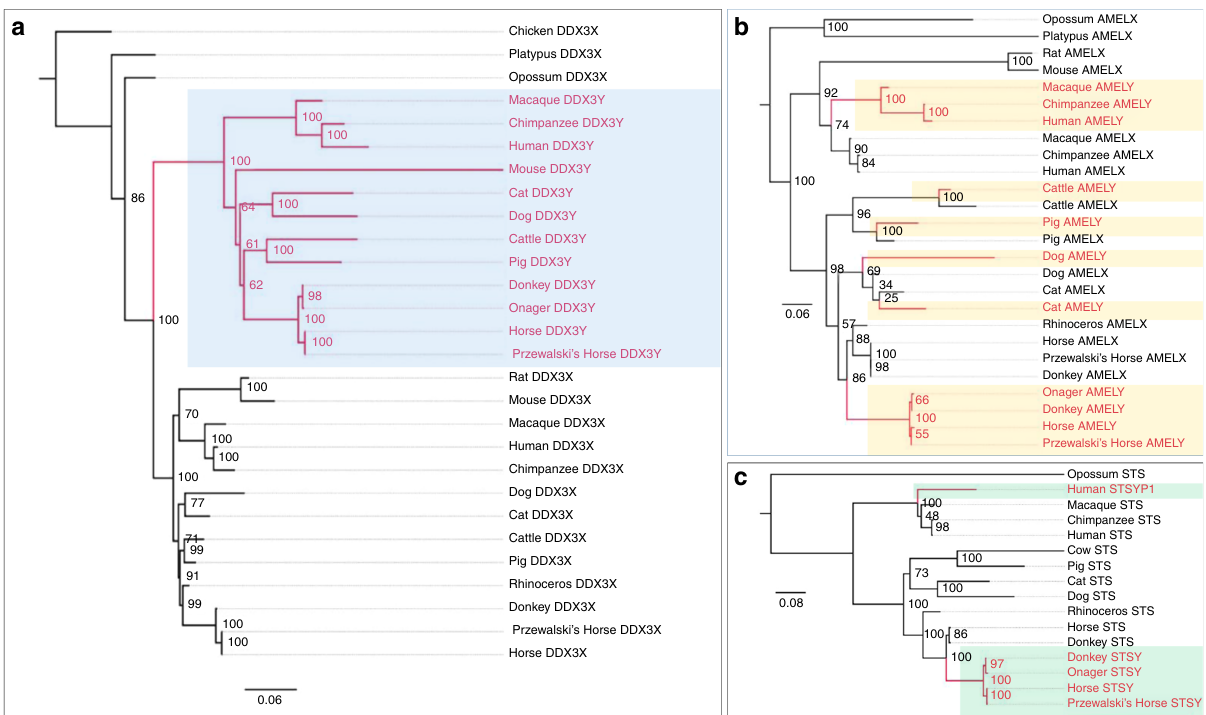
Fig. 3 Evolutionary topologies of gametologs. Maximum likelihood phylogenies with bootstrap support values showing: a Monophyletic (e.g., DDX3Y) and ( b - c ) Polyphyletic (e.g., AMELY; STSY) patterns of evolution, with AMELY being broadly polyphyletic and STSY polyphyletic with two separate origins; Y orthologs in different species are highlighted with colored